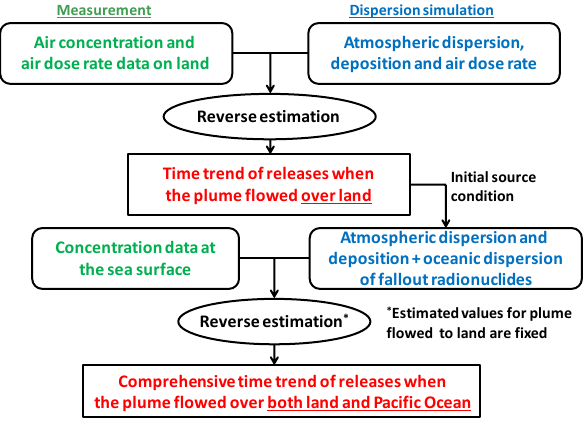
Figure 1. The flowchart of the source term estimation technique based on coupling the atmospheric and oceanic dispersion model